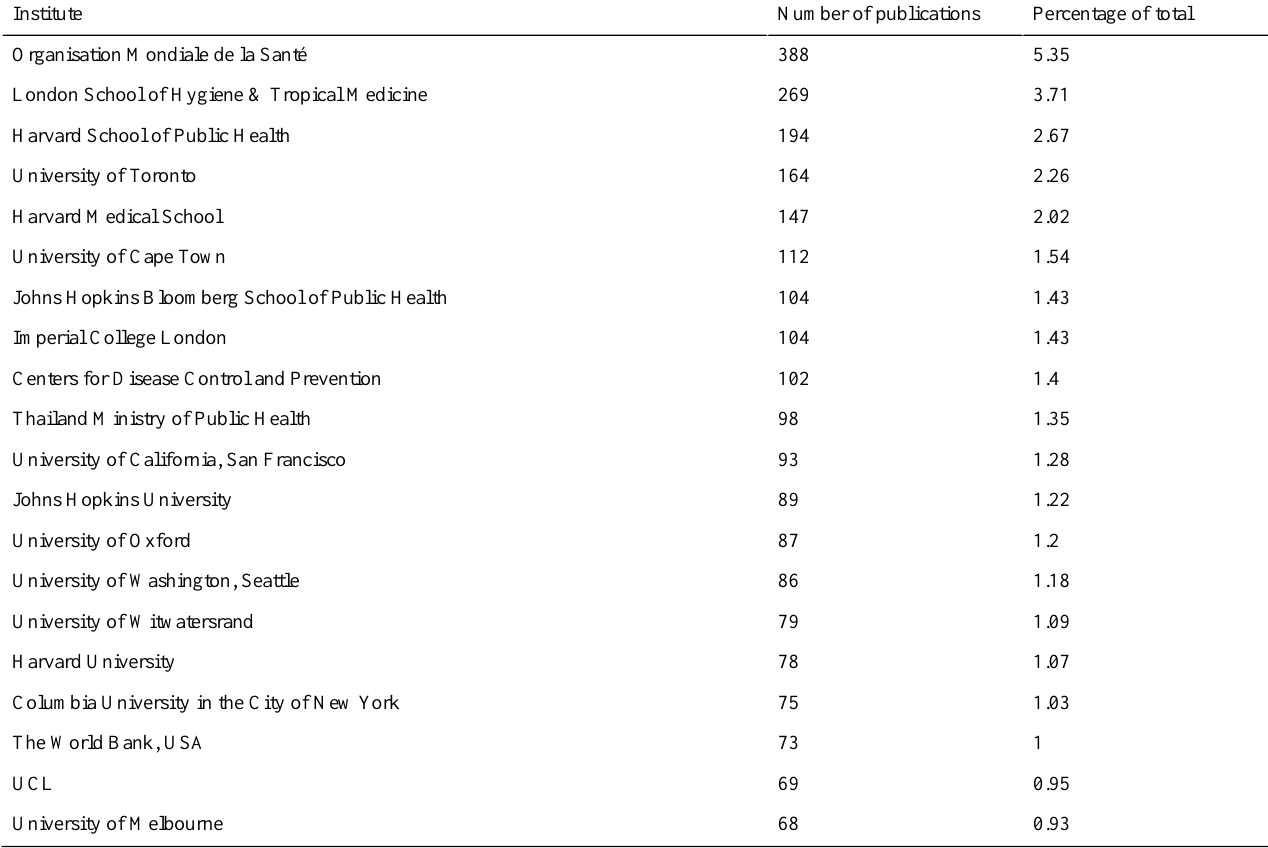
Table 5. Highest producing institutes and research centers for universal health coverage